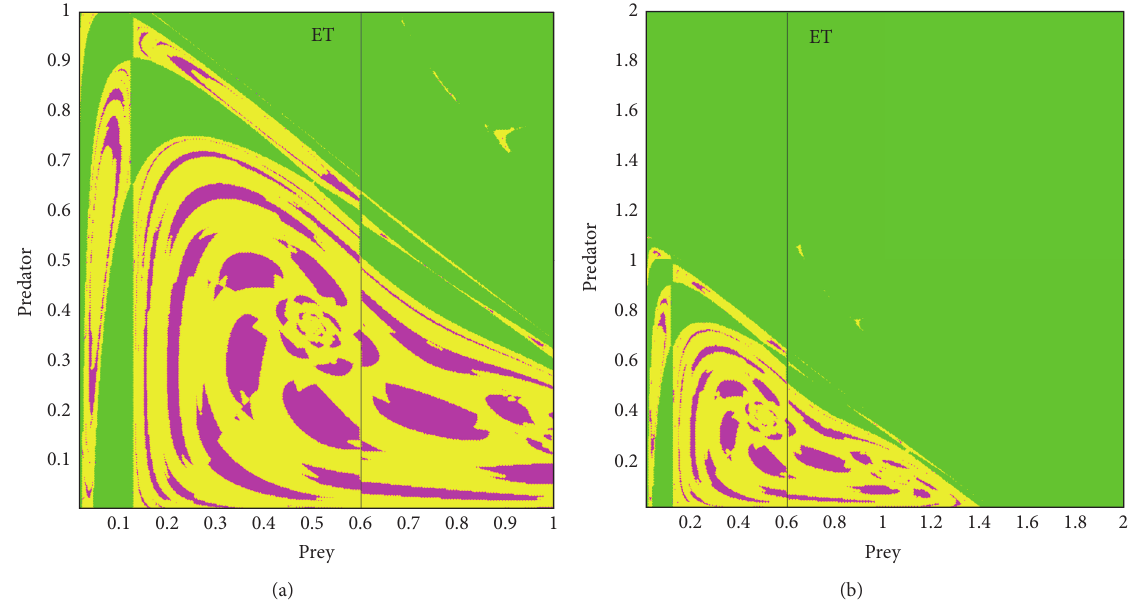
Figure 5: Basins of attraction of four coexisting attractors of system (6); the horizontal axis and the vertical axis are the prey and predator initial values 𝑥 0 and 𝑦 0 , respectively. (a) Basin of attraction of two periodic solutions shown in Figure 4 and one infinity solution, where the intervals of initial values are 0 ≤ 𝑥 0 ≤ 1 and 0 ≤ 𝑦 0 ≤ 1 ; (b) 0 ≤ 𝑥 0 ≤ 2 and 0 ≤ 𝑦 0 ≤ 2 . The other parameters are fixed the same as Figure 4. The magenta regions represent Figures 4(a) and 4(b) attractor, the yellow regions are related to Figures 4(c) and 4(d) attractor, and the green region represents infinity attractor.